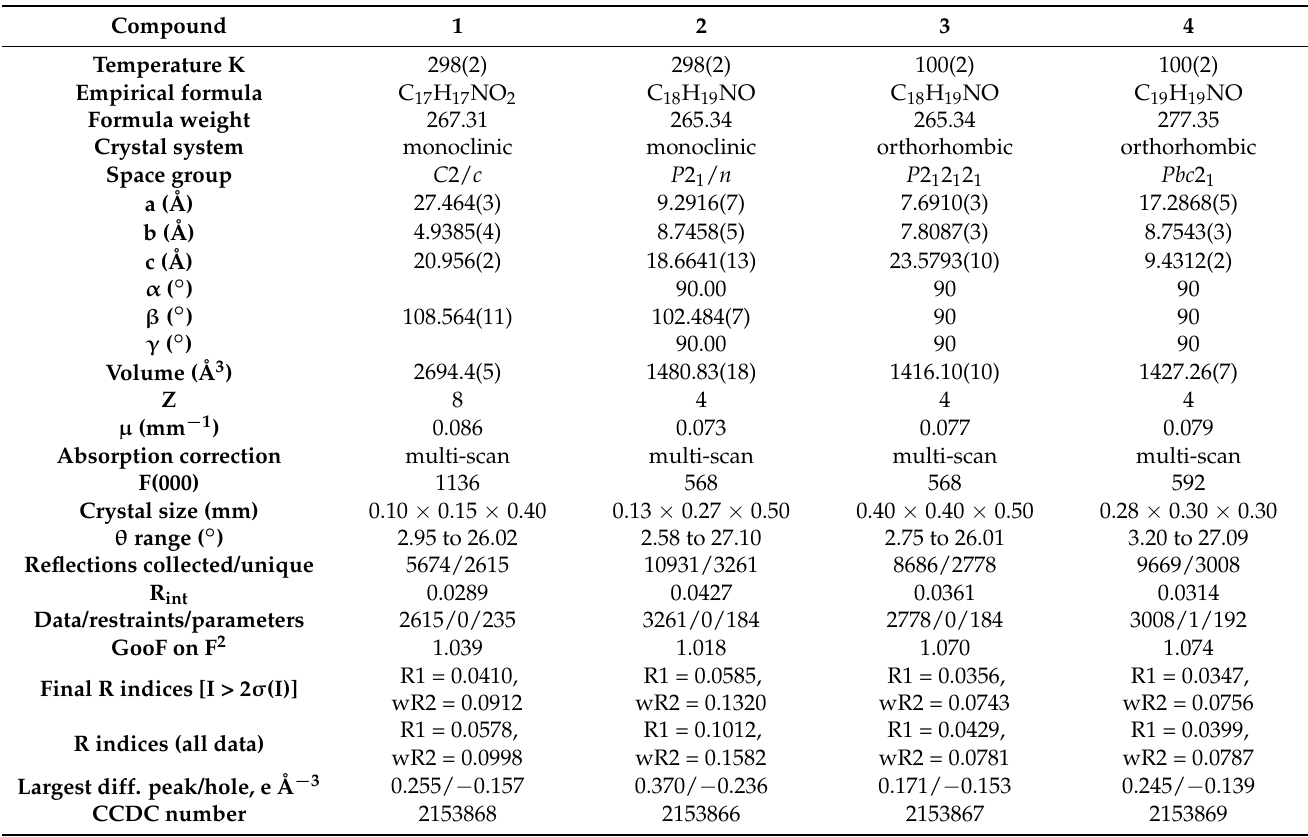
Table 3. Crystal data and structure refinement of 1 – 4